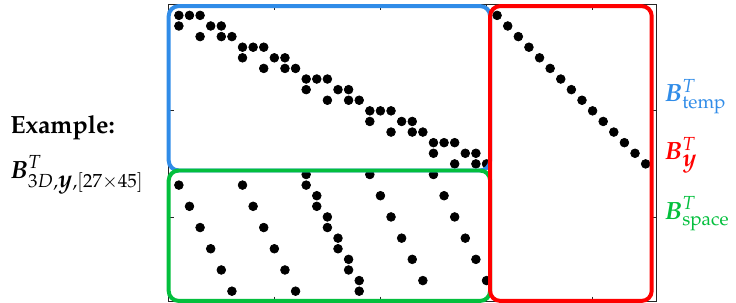
Figure 4. Exemplary structure of a global constraint matrix with slack variables for a small D-InSAR stack consisting of six interferograms between which a total of three temporal constraints can be generated and five spatial gradients between which two spatial constraints must be